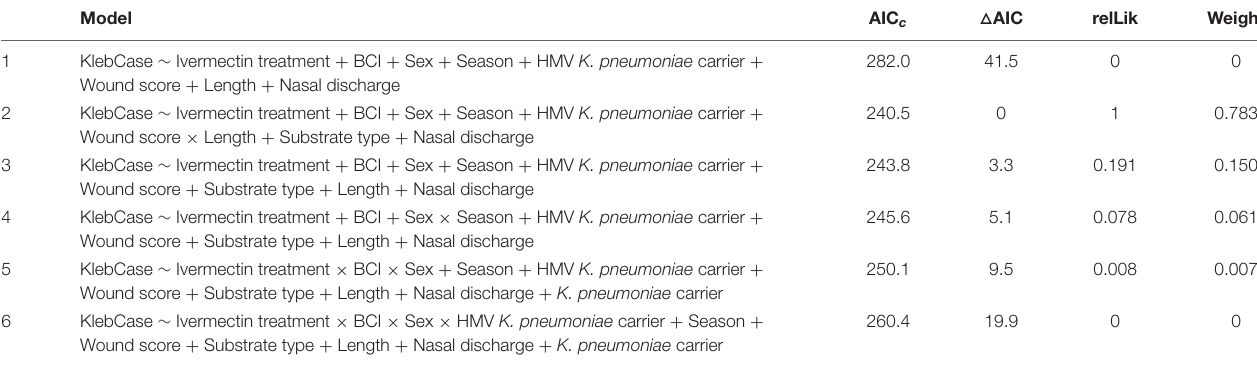
TABLE 2 | Summary of predictor variables used in six candidate models for generalized linear model analysis and Akaike information criterion (AIC) statistics for hypervirulent Klebsiella pneumoniae mortality in New Zealand sea lion ( Phocarctos hookeri ) pups at Sandy Bay, Enderby Island.